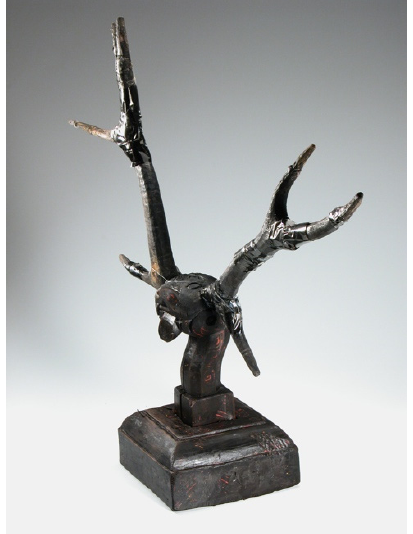
Figure 6. Antlered and tongued sculpture from Tomb 134 at Yugang, Xiangyang County, Hubei. From Xiangyang shi wenwu kaogu yanjiusuo (2011b, color plate 45.2).